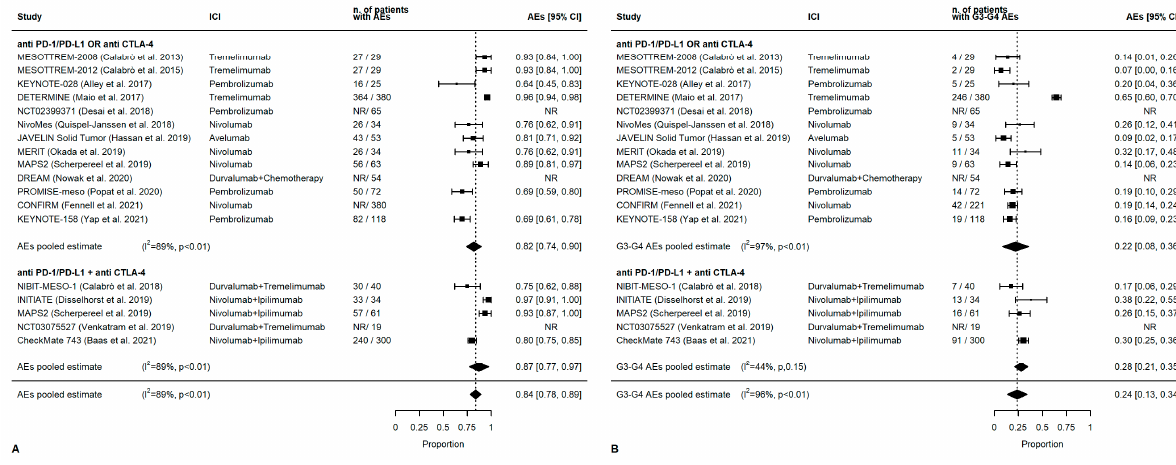
Figure 3. AEs. ( A ) Any grade, ( B ) G3-G4.